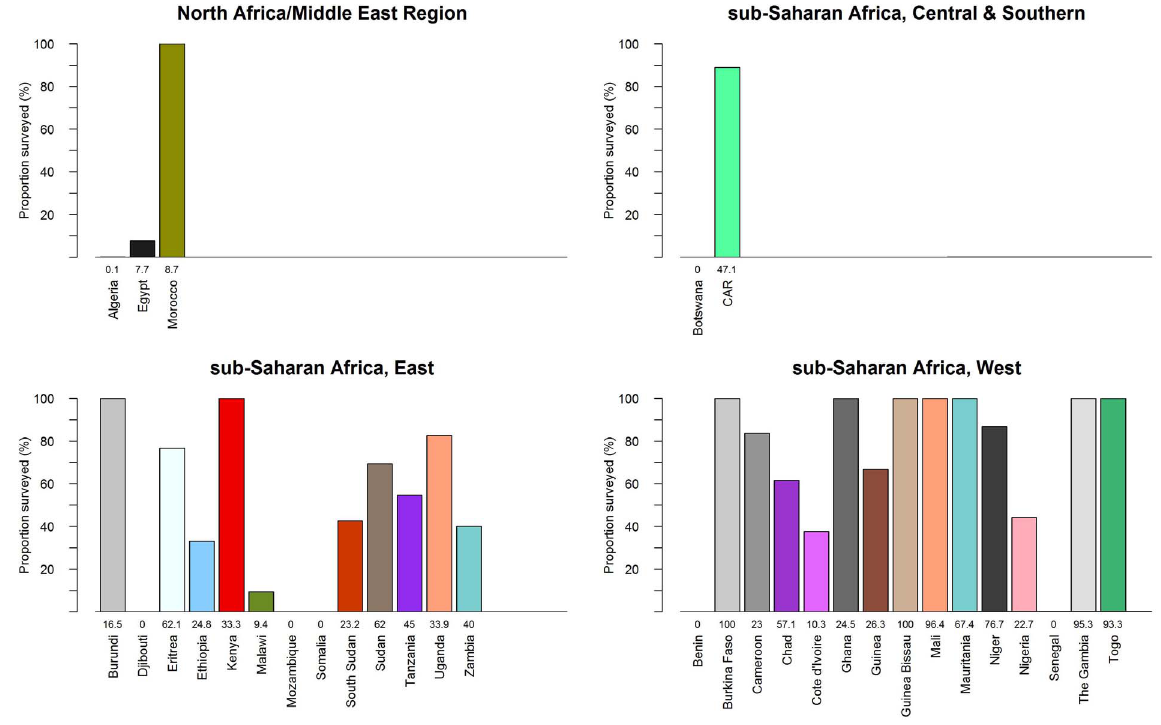
Figure 2. Proportion of districts surveyed by population based prevalence surveys between 1985 and 2012 in Africa. Bar plots exclude non-endemic areas from the denominator where information on suspected endemicity is available for the entire country, while numbers indicate the proportion of all districts surveyed. The graph highlights progress in mapping many endemic countries in east and west sub-Saharan Africa and the need for additional surveys in many countries in Africa.